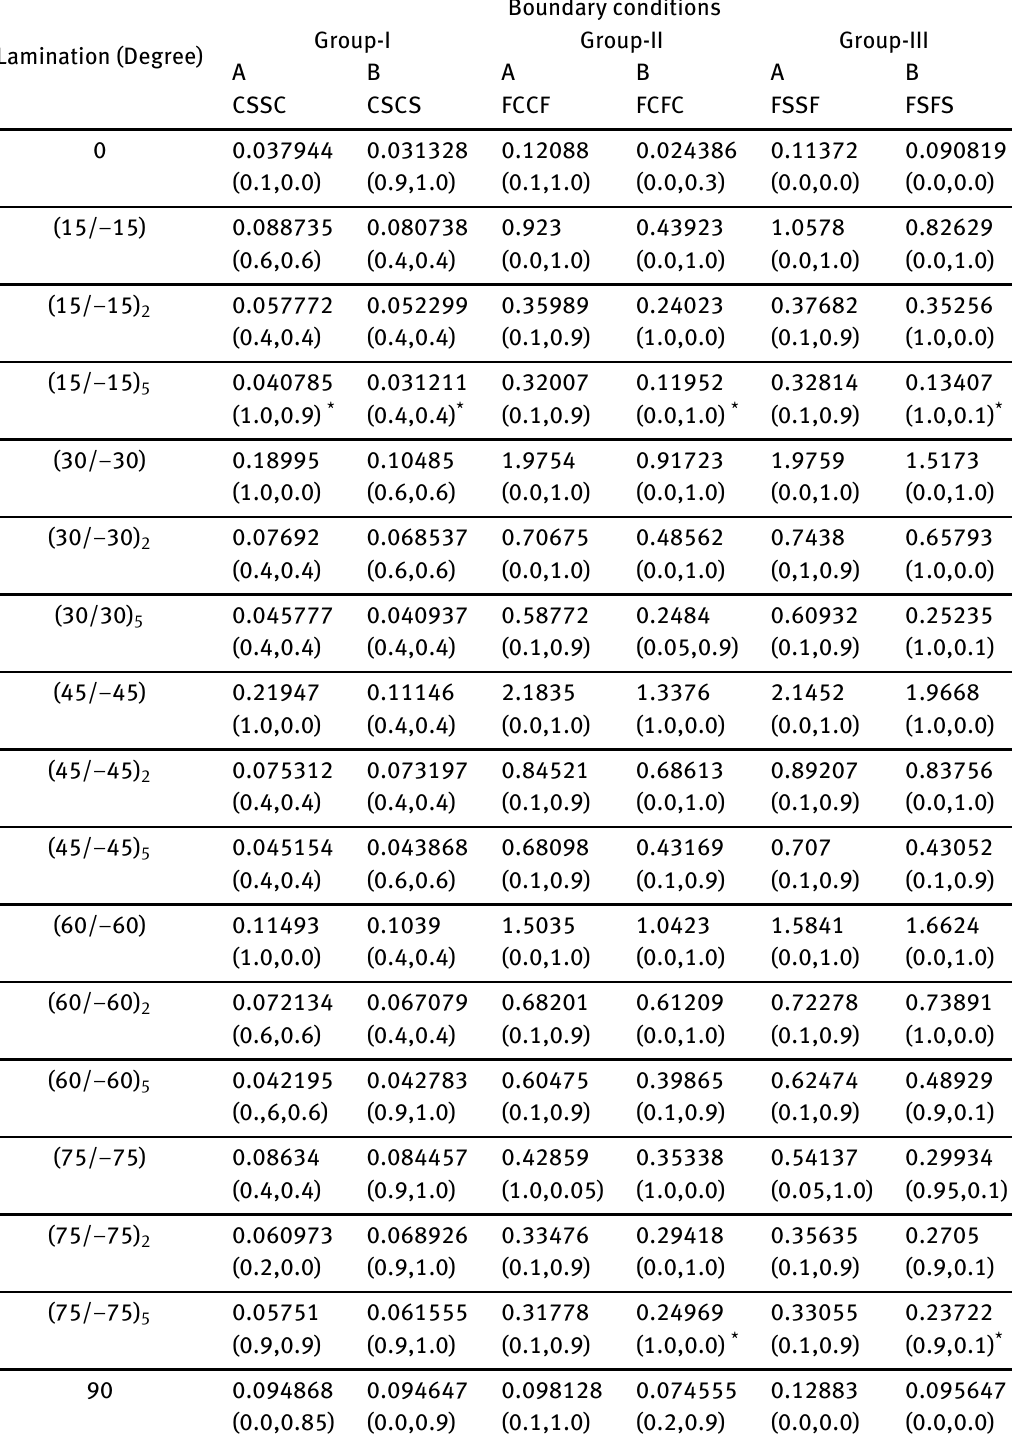
Table 14: Values of maximum non-dimensional anticlockwise twisting moments (+ M xy ) x 10 2 for different antisymmet- ric angle ply lamination and boundary conditions of stiffened composite hypar shell with